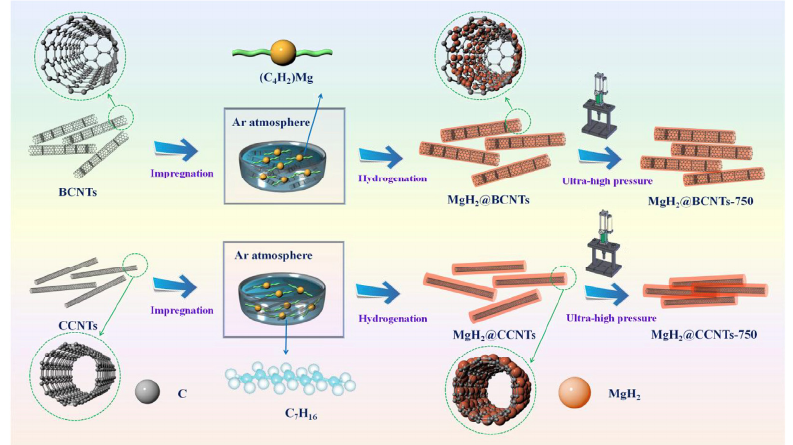
Figure 2. Schematic illustration of the self-assembly of MgH 2 NPs on the BCNTs and CCNTs by impregnation and hydrogenation and densification under ultra-high pressure of 750 MPa. Copyright 2019, Elsevier. Reproduced with permission from [55].